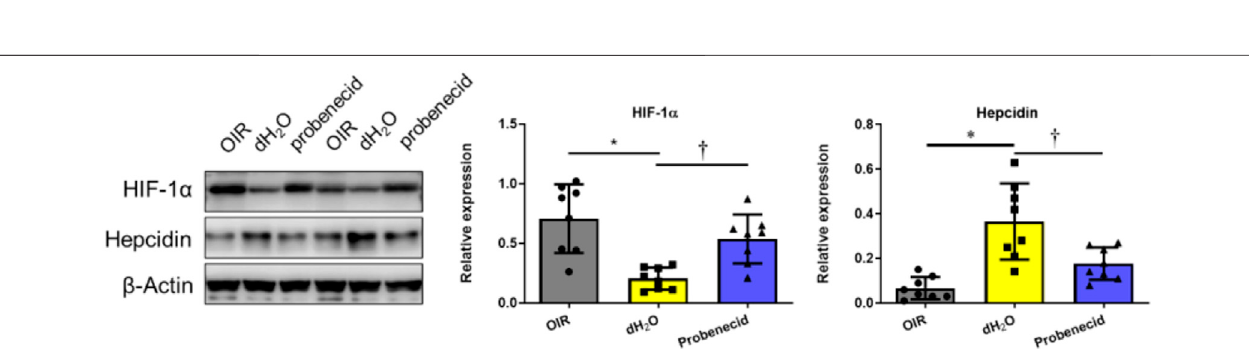
FIGURE5| ProbenecidinhibitsoverproductionofhepcidininducedbyhyperoxiainOIRratsweretreatedwithprobenecidoranequivalentvolumeofdH 2 OfromP1 to P7. Representative bands from two different samples are shown. Bar graphs represent the relative expression level ofHIF-1 α and hepcidin. Results are expressed as mean ± SD; n (cid:2) 8 per group, * p < 0.05 vs the control group; † p < 0.05 vs O 2 + dH 2 O. Signi fi cance was determined by one-way ANOVA with Bonferroni ’ s multiple comparisons